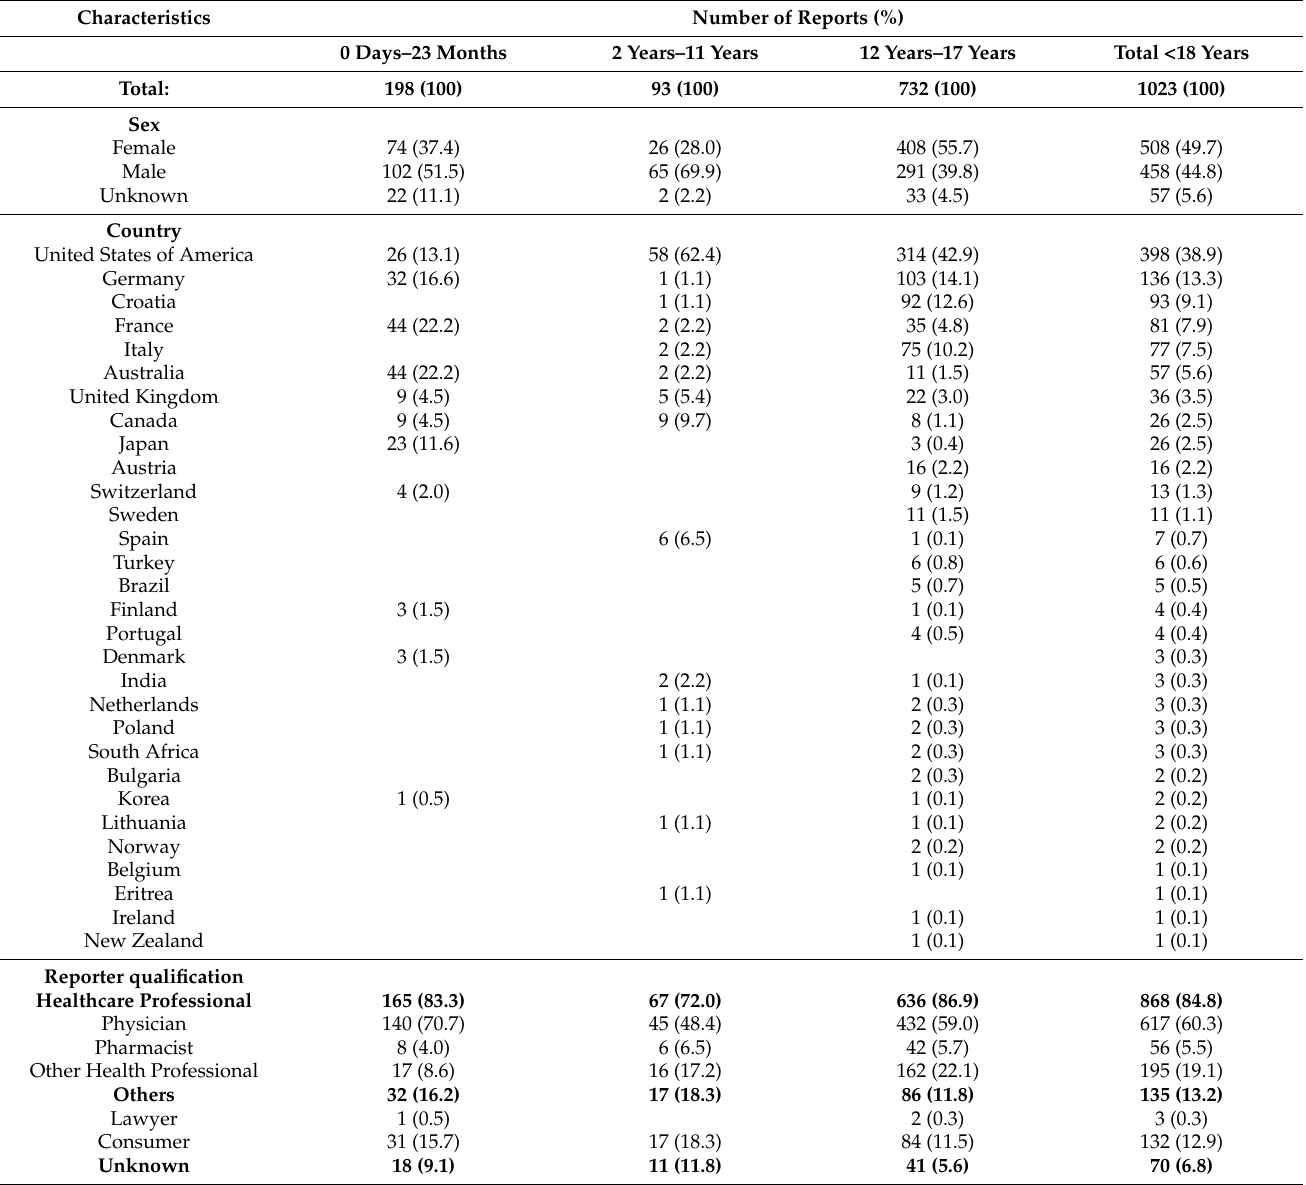
Table 1. Characteristics of the reports of patients with abuse, dependence, or